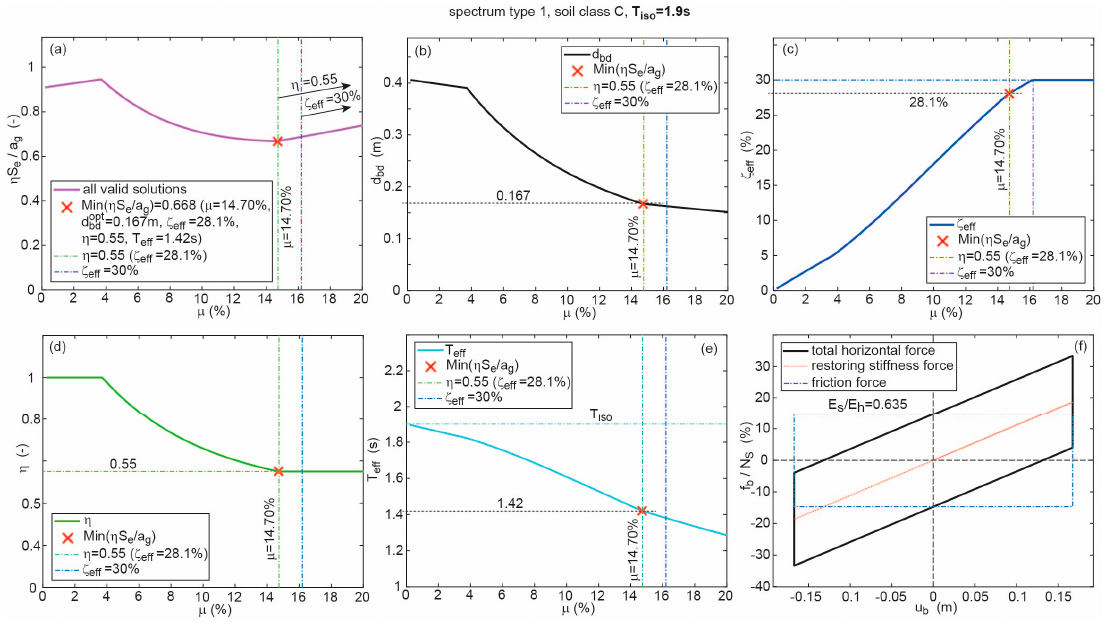
Figure 4. ( a – e ) Optimization results for T iso = 1.9 s as function of friction coefficient and ( f ) force displacement curve of optimum CSS design for spectrum type 1 with soil class C. E s : elastic energy; E h : dissipated energy; u b : isolator relative displacement.